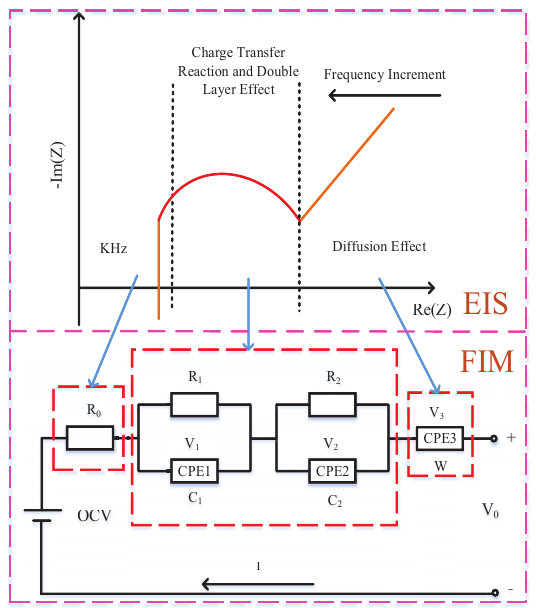
Figure 1. The EIS-FIM representation of LIBs. Based on the above discussion, a FIM of LIB is drawn in the bottom part of Figure 1. The relevant circuit elements corresponding to the three regions of the EIS curve are represented. In the model, OCV denotes open circuit voltage, I represents the discharge current, V 0 stands for the terminal voltage, C 1 , C 2 and W are the CPE coefficients, R 1 and R 2 are the resistances on the two RC branches, V 1 and V 2 represent the voltages on the RC branches, and V 3 is the voltage on the Warburg-like